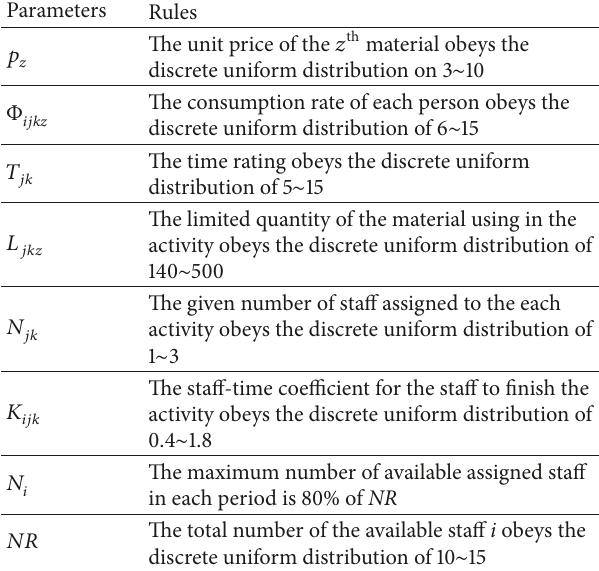
Table 3: Rules for parameters